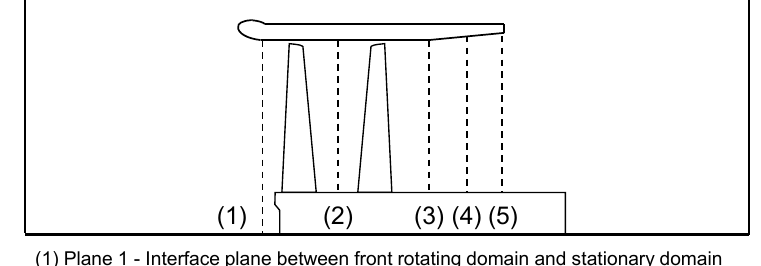
Figure 5. Total pressure contour and four relative angles between the front and rear rotors of ( a ) 0°; ( b ) 11.25°; ( c ) 22.5°; and ( d ) 33.75° at Plane 3, when s = 200 mm, θ = 6°, and ω R = 2700 rpm. Refer to Figure 6 for the location of Plane 3.